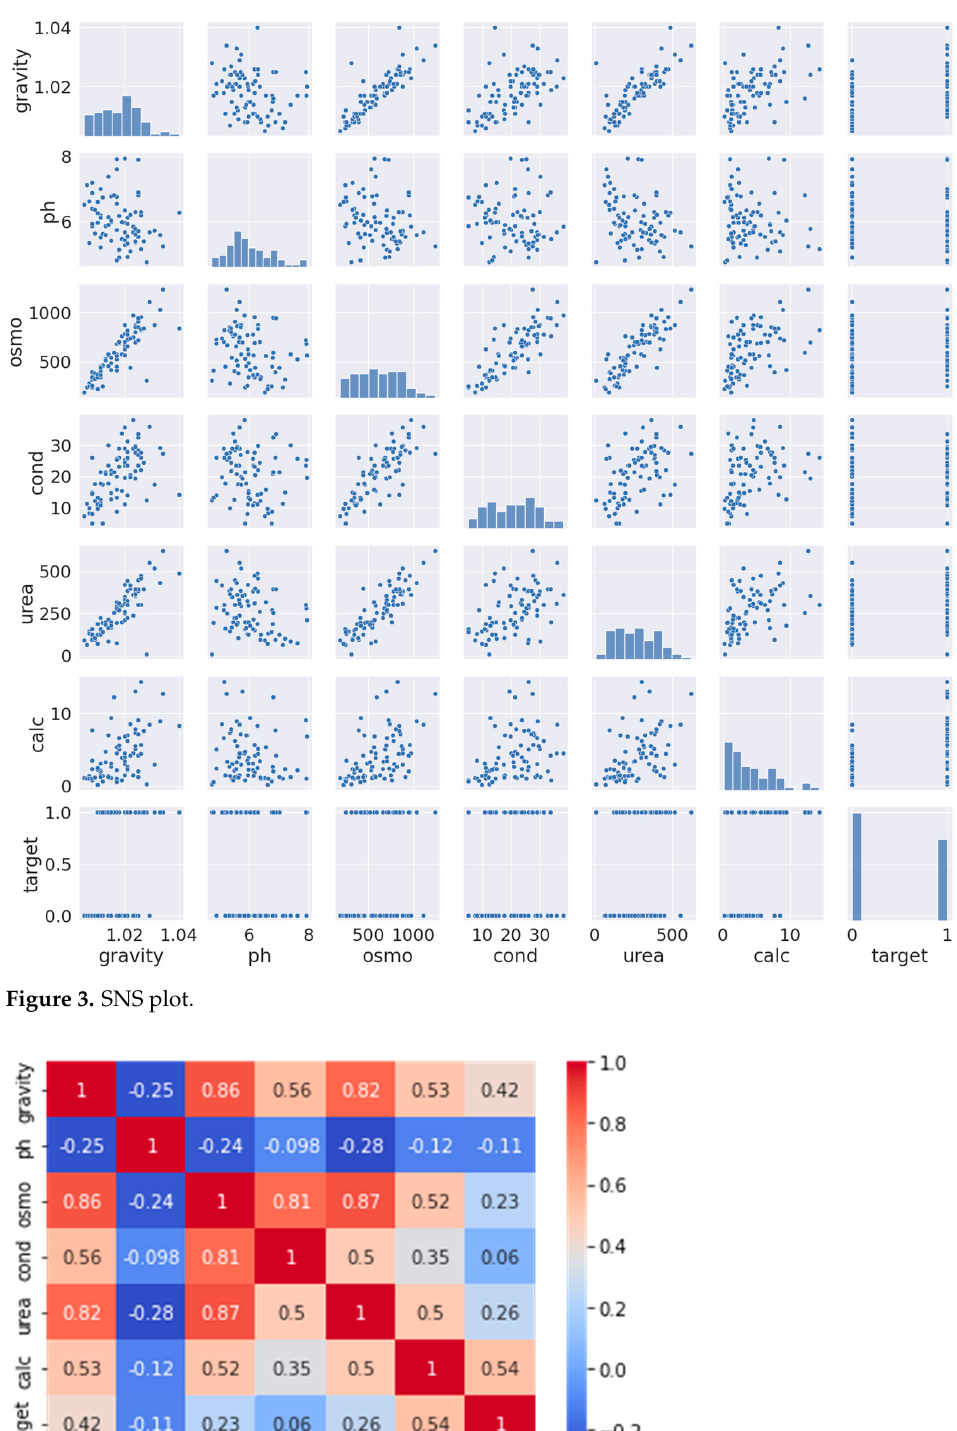
Figure 4. Correlation matrix.